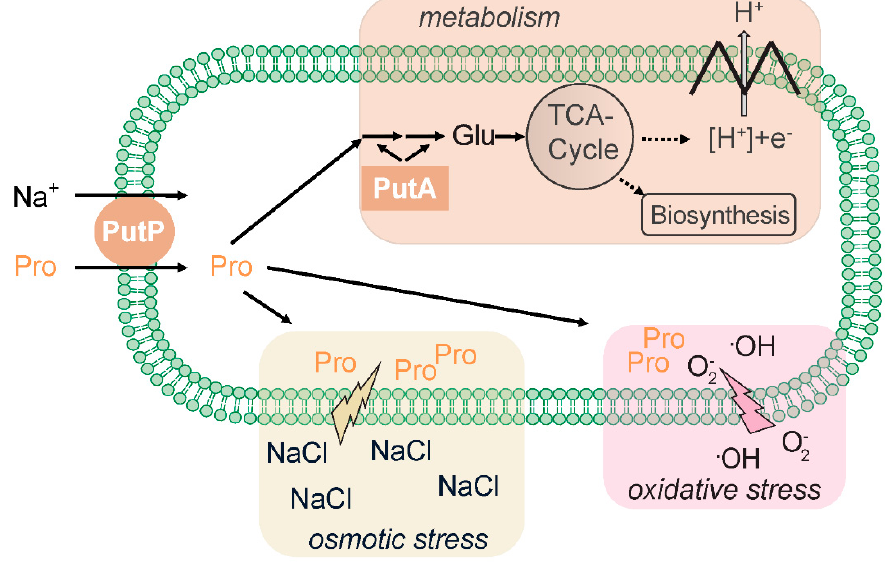
Figure 1. Possible roles of PutP in the proline metabolism of Figure 1 . Possible roles of PutP in the proline metabolism of prokaryotes.